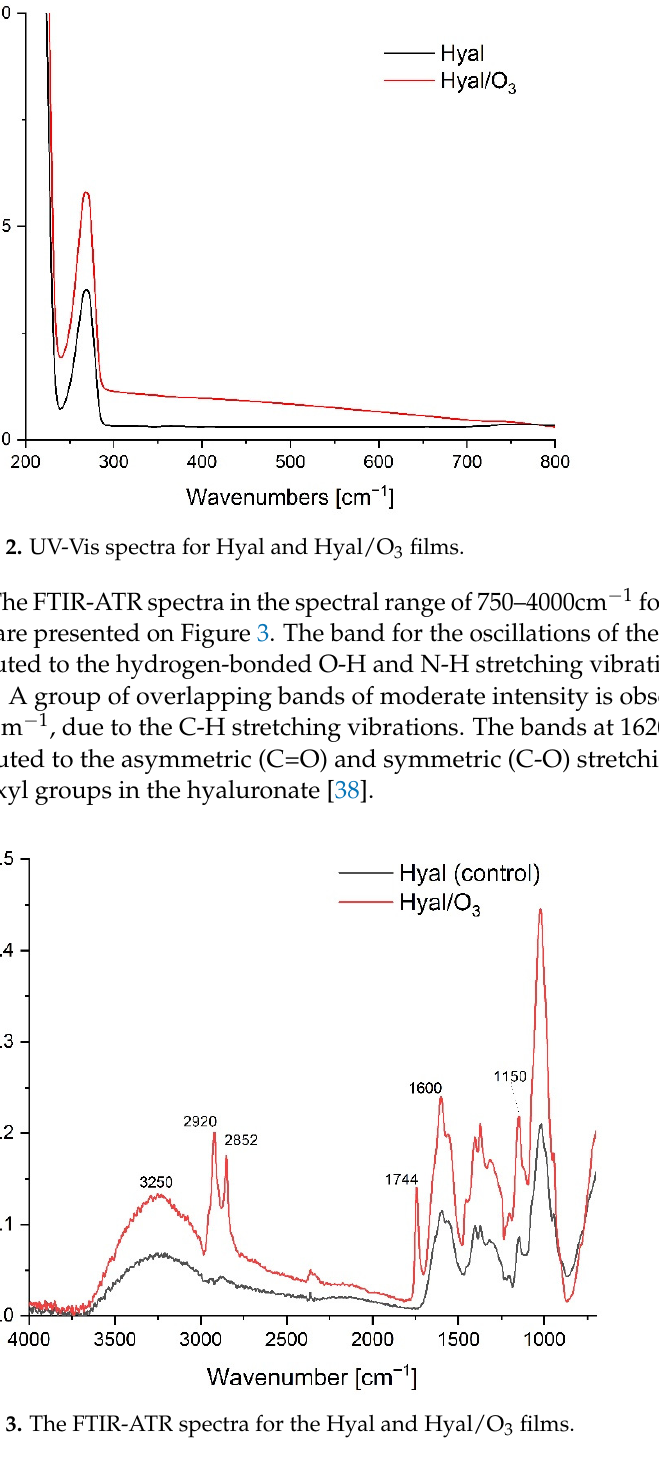
Figure 3. The FTIR ‐ ATR spectra for the Hyal and Hyal/O 3 films.